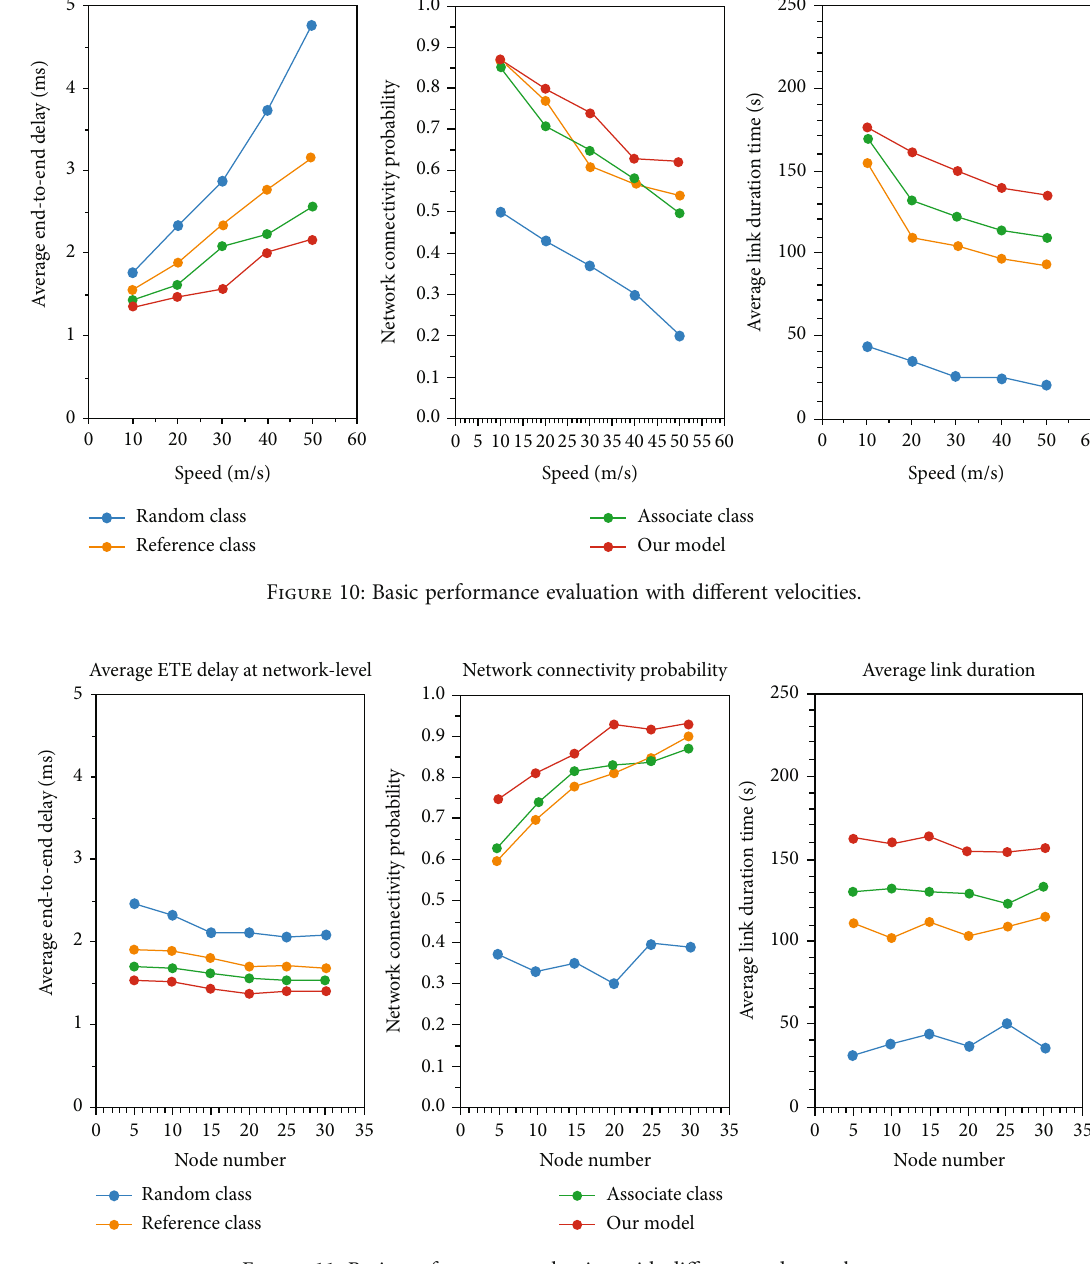
Figure 11: Basic performance evaluation with di ff erent node numbers. Table 7: The performance of di ff erent reference node selection